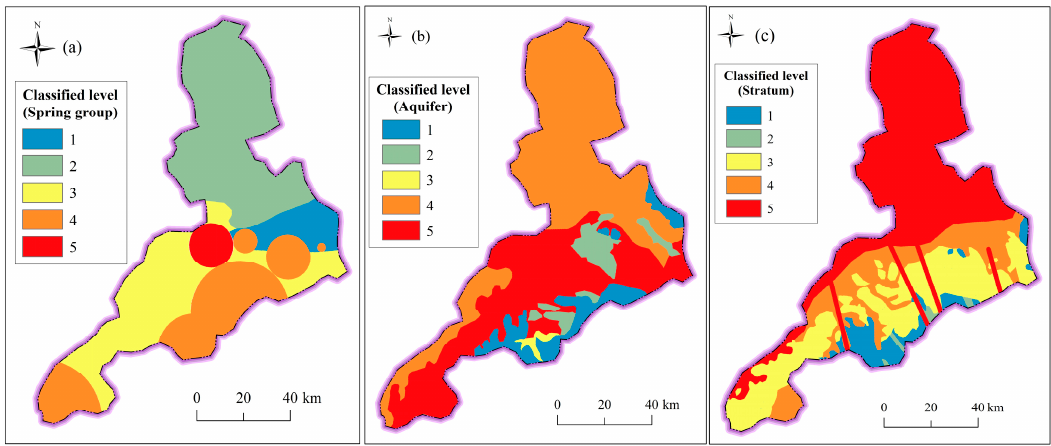
Figure 12. Classified level of underground index: ( a ) spring groups; ( b ) aquifer; and ( c ) stratum. Table 3. Hydraulic characteristics and classification of aquifer in Jinan City.